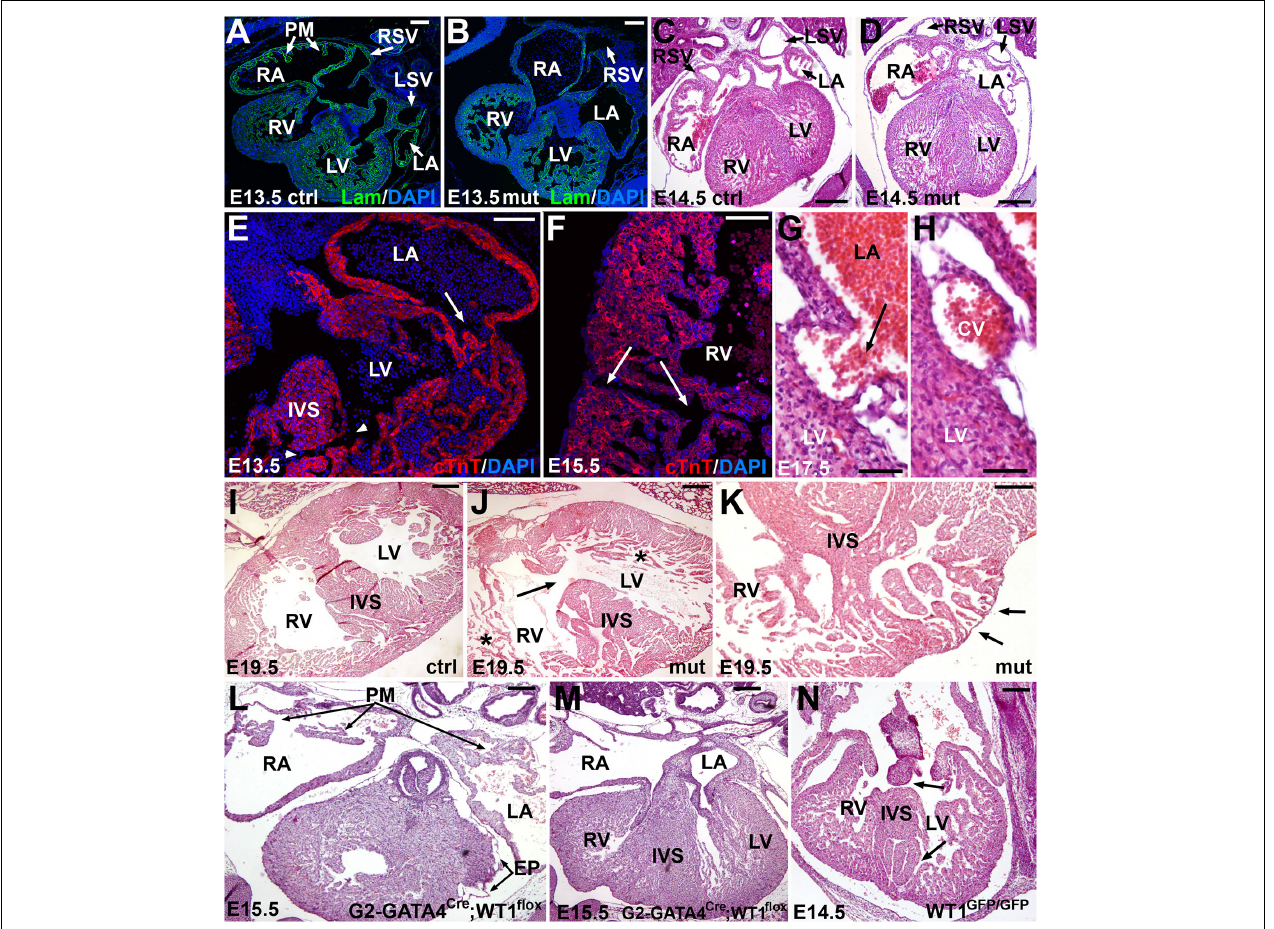
FIGURE 4 | Embryonic phenotype of the conditional WT1 loss of function in cardiomyocytes (Tnnt2 Cre / + ; WT1 flox / flox line). Representative images obtained from the analysis of 14 mutant embryos. (A–D) General view of the heart in control (A,C) and mutant (B,D) embryos, stages E13.5 and E14.5. Mutant embryos show thinner ventricular walls, defective sinus venosus (shown in more detail in Figure 5 ) and lack of pectinate muscles (PM) in the right atrium (RA). RV: right ventricle; LA: left atrium; LV: left ventricle; RSV: right sinus venosus; LSV: left sinus venosus. (E–H) Defects in the myocardial walls and interventricular septum (IVS) found in mutant embryos. These defects include abnormal atrioventricular connection and muscular IVS defect (arrow and arrowheads in E ), discontinuities in the right ventricular (RV) free wall (arrows in F ) and connection of the left atrial (LA) lumen with a subepicardial coronary vein (CV) (G,H) . (I,J) IVS defect (arrow), thin compact myocardium and hypertrabeculation (asterisks) in an E19.5 mutant embryo (J) compared with a control of the same age (I) . (K) The lack of compaction of the left ventricular apex causes a diverticulum protruding in the surface of the heart (arrows). Note the lack of compact myocardium at the base of the IVS. (L,M) Representative E15.5 embryo of the G2-GATA4 Cre ;WT1 flox model of conditional deletion of WT1 in lateral mesoderm, including septum transversum and pro/epicardium (Cano et al., 2016). The main features of this phenotype are the defective sinus venosus and epicardium (EP), but the development of the pectinate muscles (PM) and the interventricular septum (IVS) are normal. (N) Systemic deletion of WT1 (homozygous knockin Wt1 GFP / GFP , Hosen et al., 2007), E14.5, respectively. This is the most advanced stage reached by these mutant embryos. Note the defects in the IVS (arrows). Scales: 50 µ m and except (C–E) (100 µ